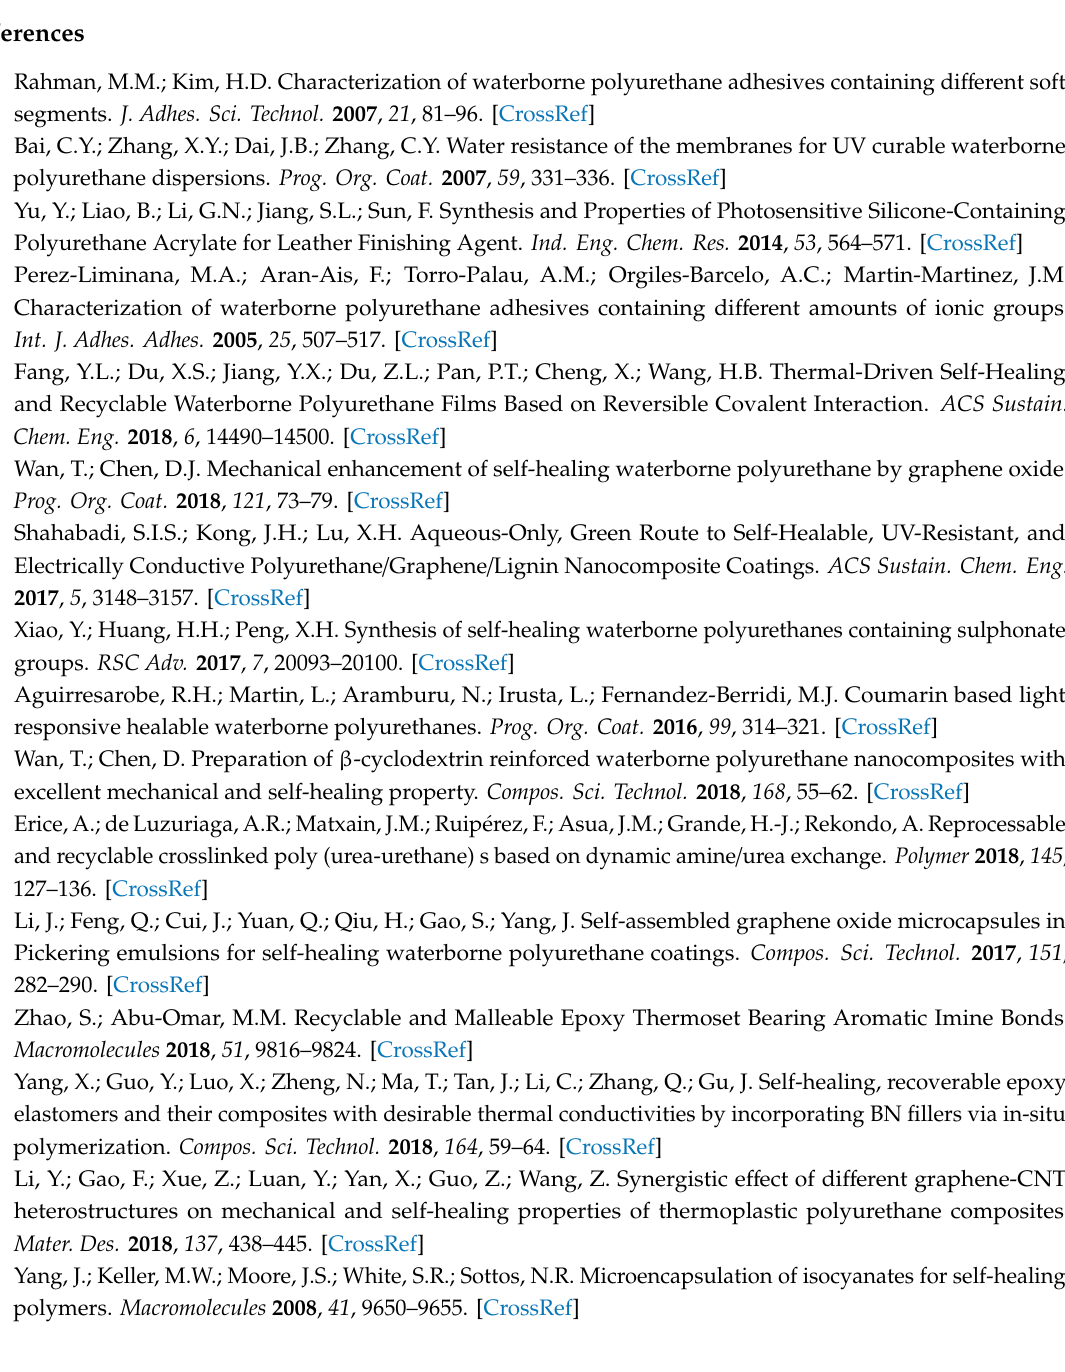
test of WPU-cystamine films, Table S4: Glass transition temperature of heat-treated WPU-EDA, Table S5: Glass transition temperature of heat-treated